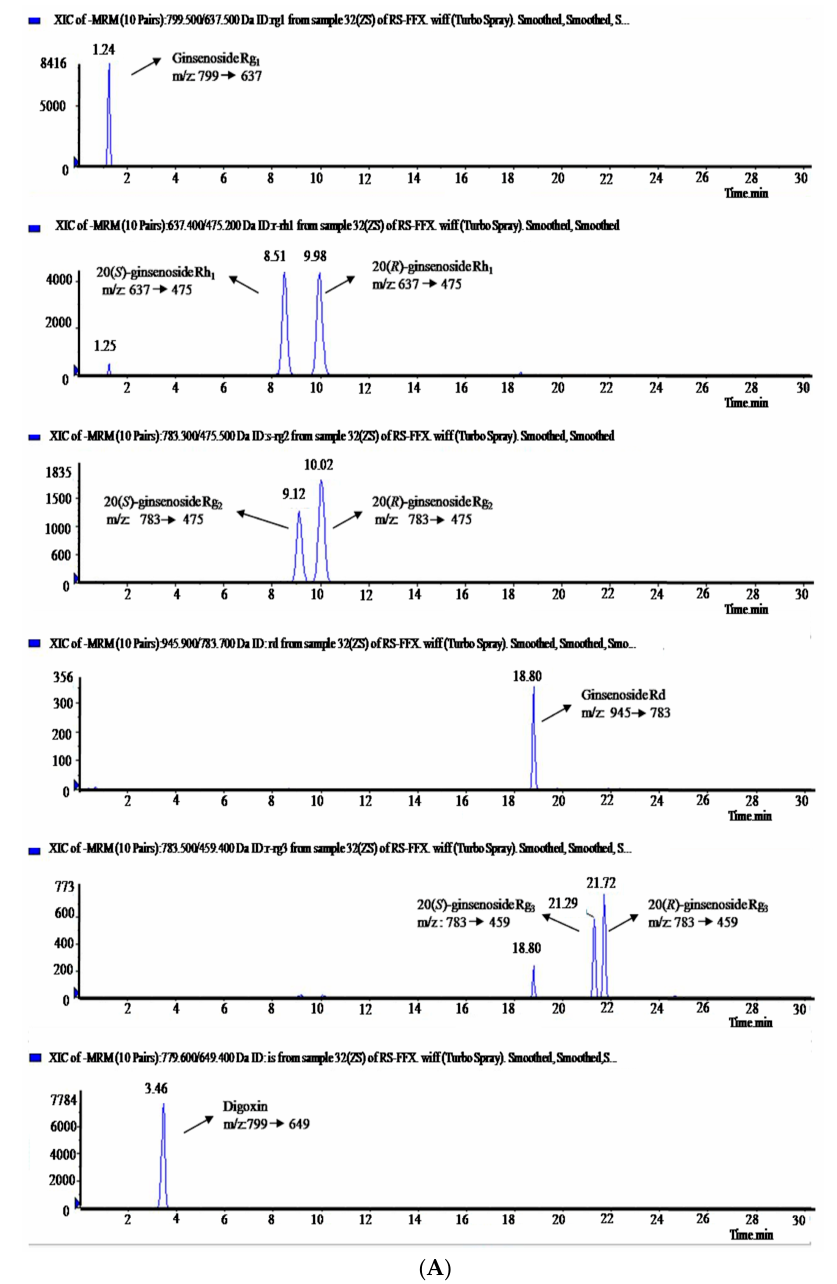
Figure 2. Cont. Figure 2.